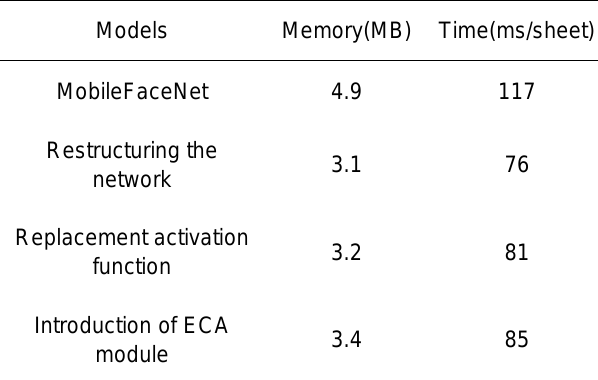
Table 4. Model Complexity Test